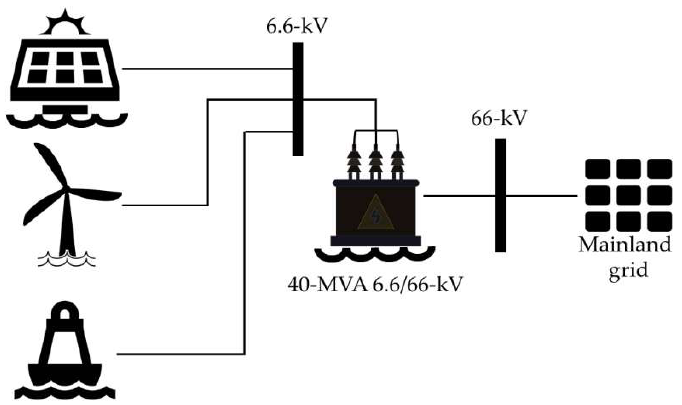
Figure 1. Multi-source park studied in the proposed approach.